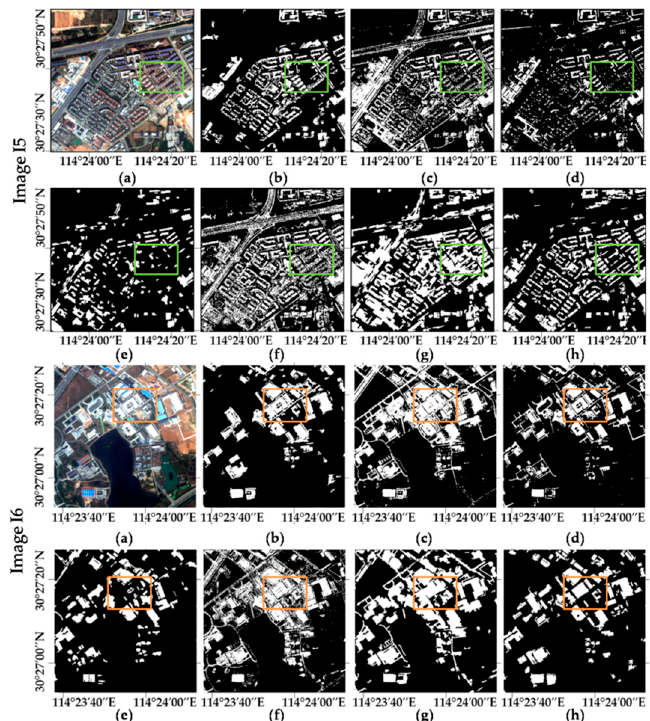
Figure 11. Building detection results of Test Patches I5 and I6. ( a ) RGB image; ( b ) MBI results; ( c – e ) the building maps with the results of the pixel-based SVM, DMP-SVM, and object-oriented SVM, respectively; ( f , g ) DMP-RF and object-oriented RF results; ( h ) the proposed method results.